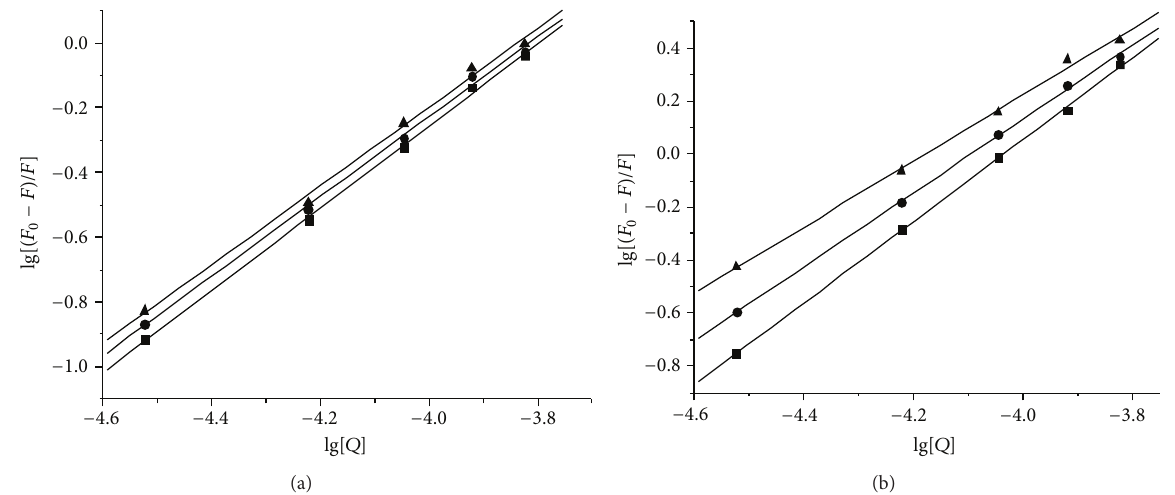
Figure 5: Plots of lg[( 𝐹 0 − 𝐹 )/ 𝐹 ] versus lg[ 𝑄 ] for the fluorescence quenching of DNA-EB system by ligand L (a) and La (III) complex (b) at different temperatures, ( 󳵳 ) 298 K; ( e ) 303 K; ( ◼ ), 310 K.